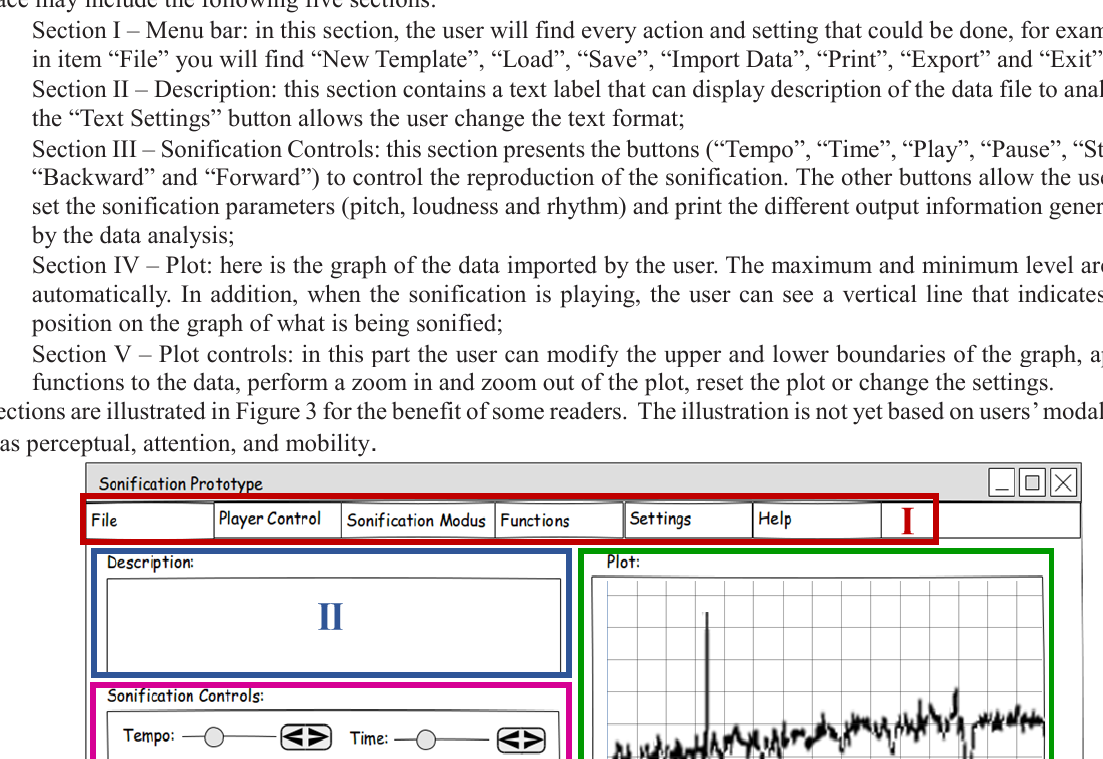
Figure 1. Results of the analysis of compliance.